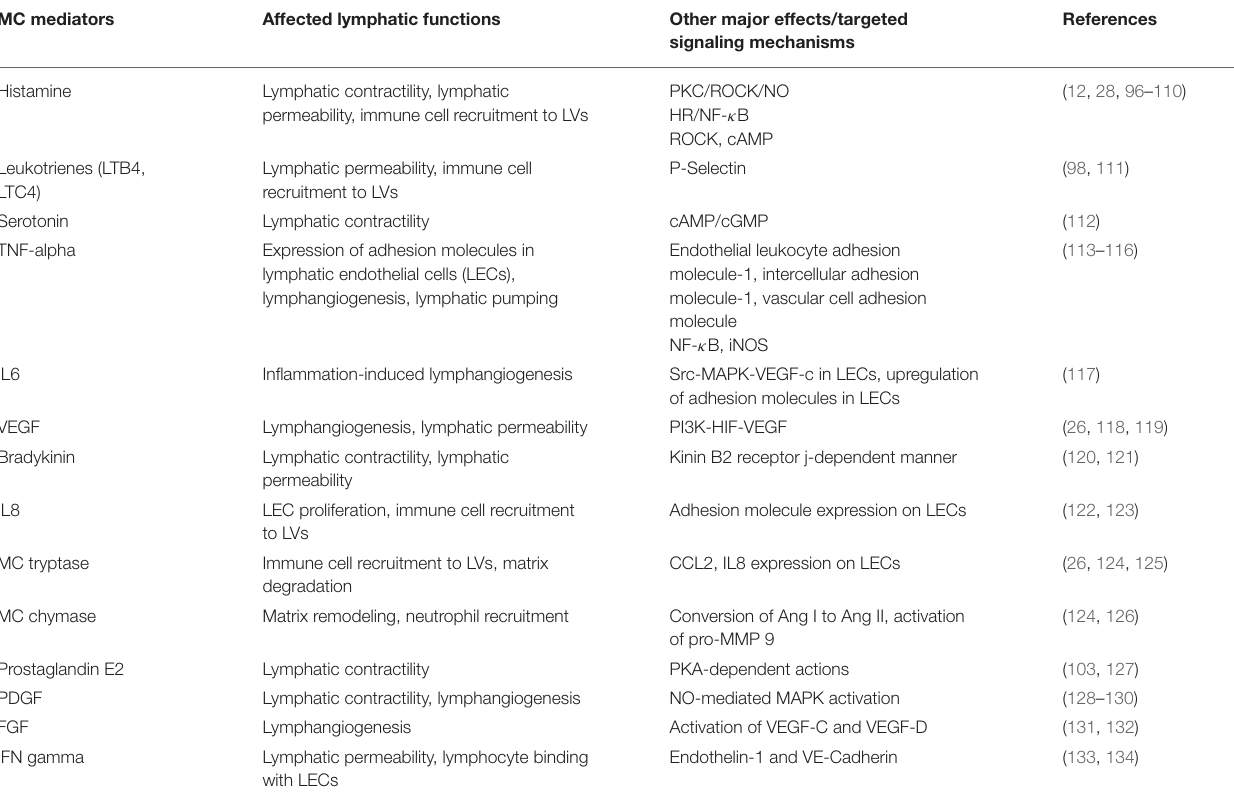
TABLE 2 | MC-derived Mediators that Regulate the Lymphatic